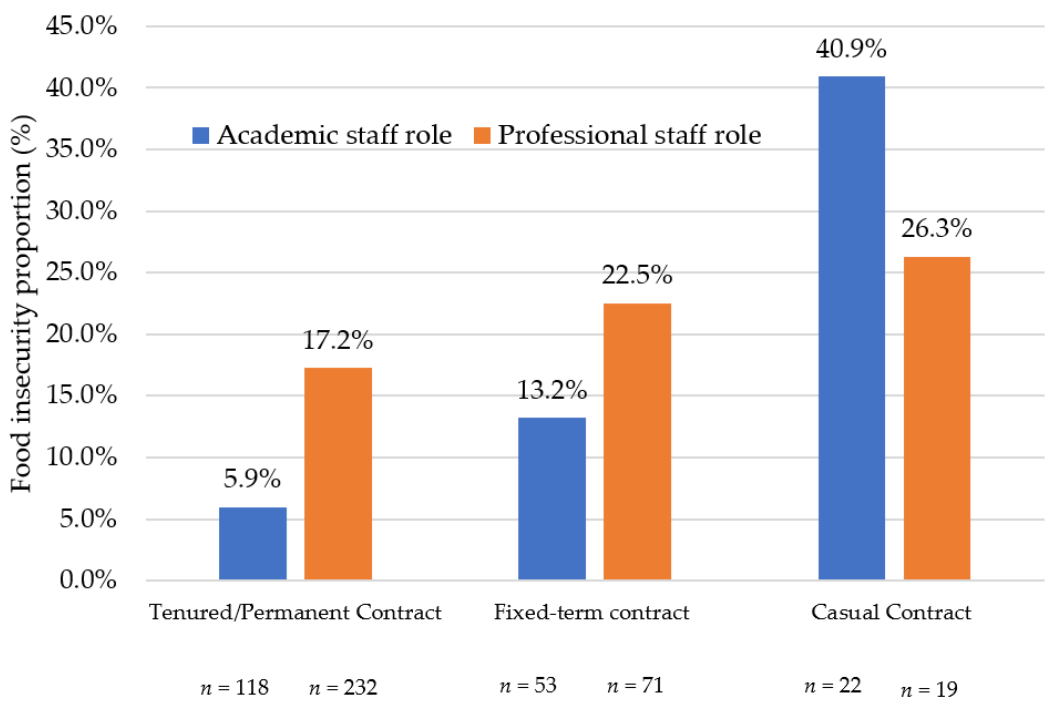
Figure 2. Percentage of academic and professional staff experiencing food insecurity according to employment contract